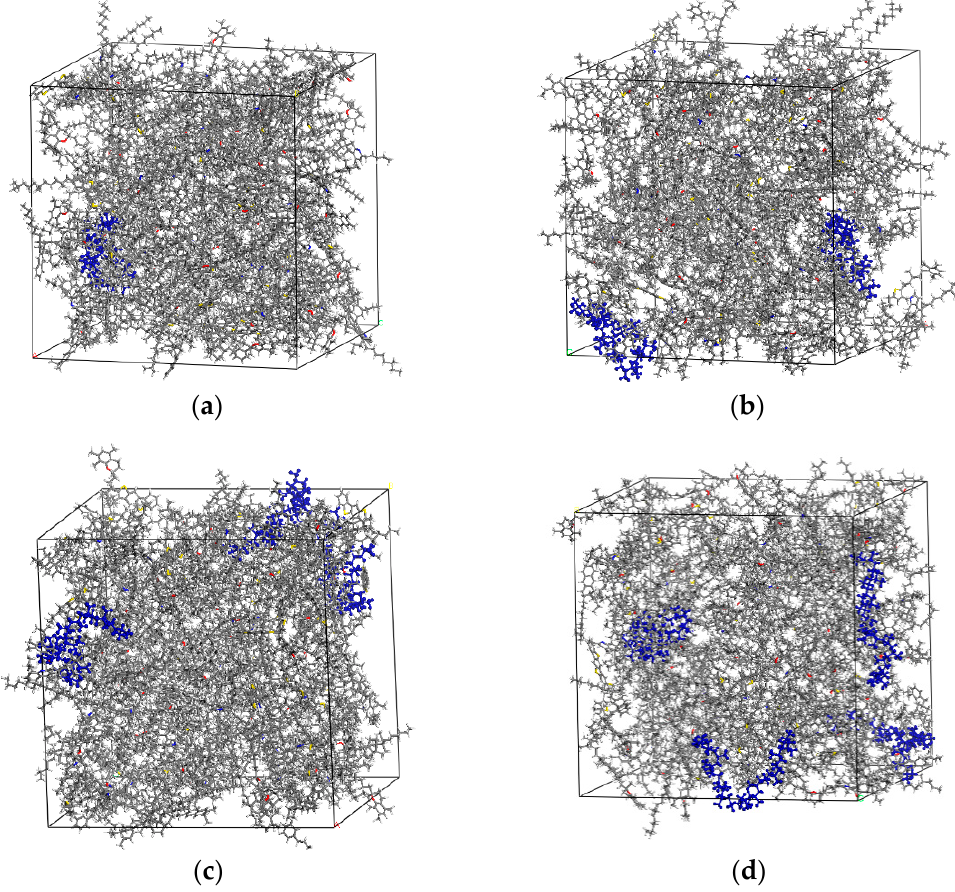
Figure 12. Steady-state DM-modified asphalt model. ( a ) DM1-modified asphalt model; ( b ) DM2- modified asphalt model; ( c ) DM3-modified asphalt model; ( d ) DM4-modified asphalt model. The blue part is the polypropylene chain.